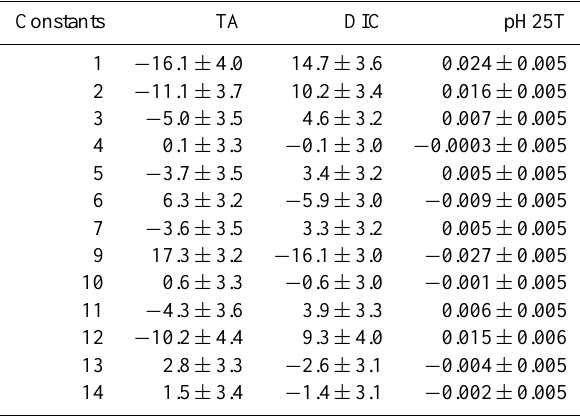
Table 1. Mean values and standard deviation of the residuals (mea- sured minus calculated) for alkalinity (TA), Dissolved Inorganic Carbon (DIC) and pH at the total scale and referred to 25 ◦ C (pH25T) calculated with different thermodynamic constants for CO 2 according to the CO2SYS programme options. The sulphate constant from Dickson (1990) and total borate concentration from Khoo et al. (1977) were used in all